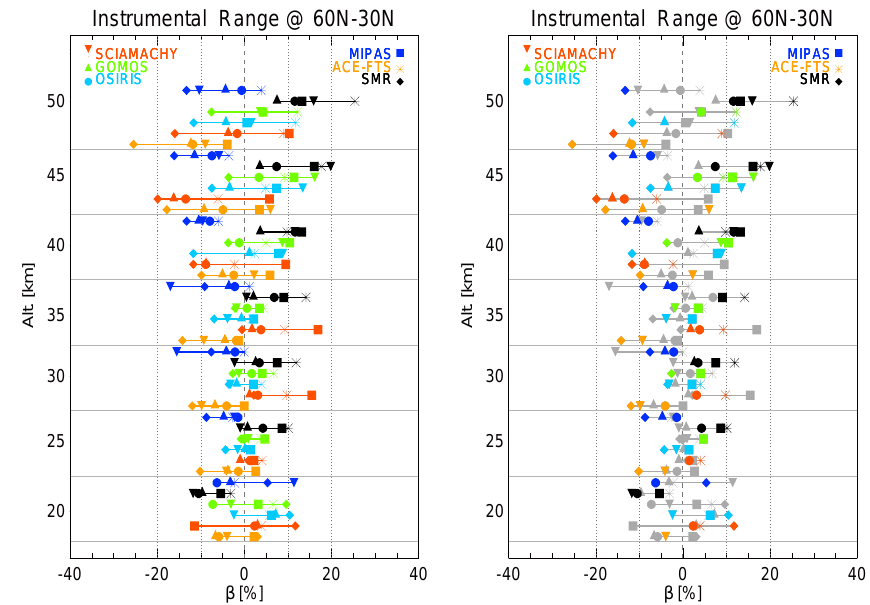
Figure 5. Same as Fig. 4 but for the northern middle latitudes (30–60 ◦ N).